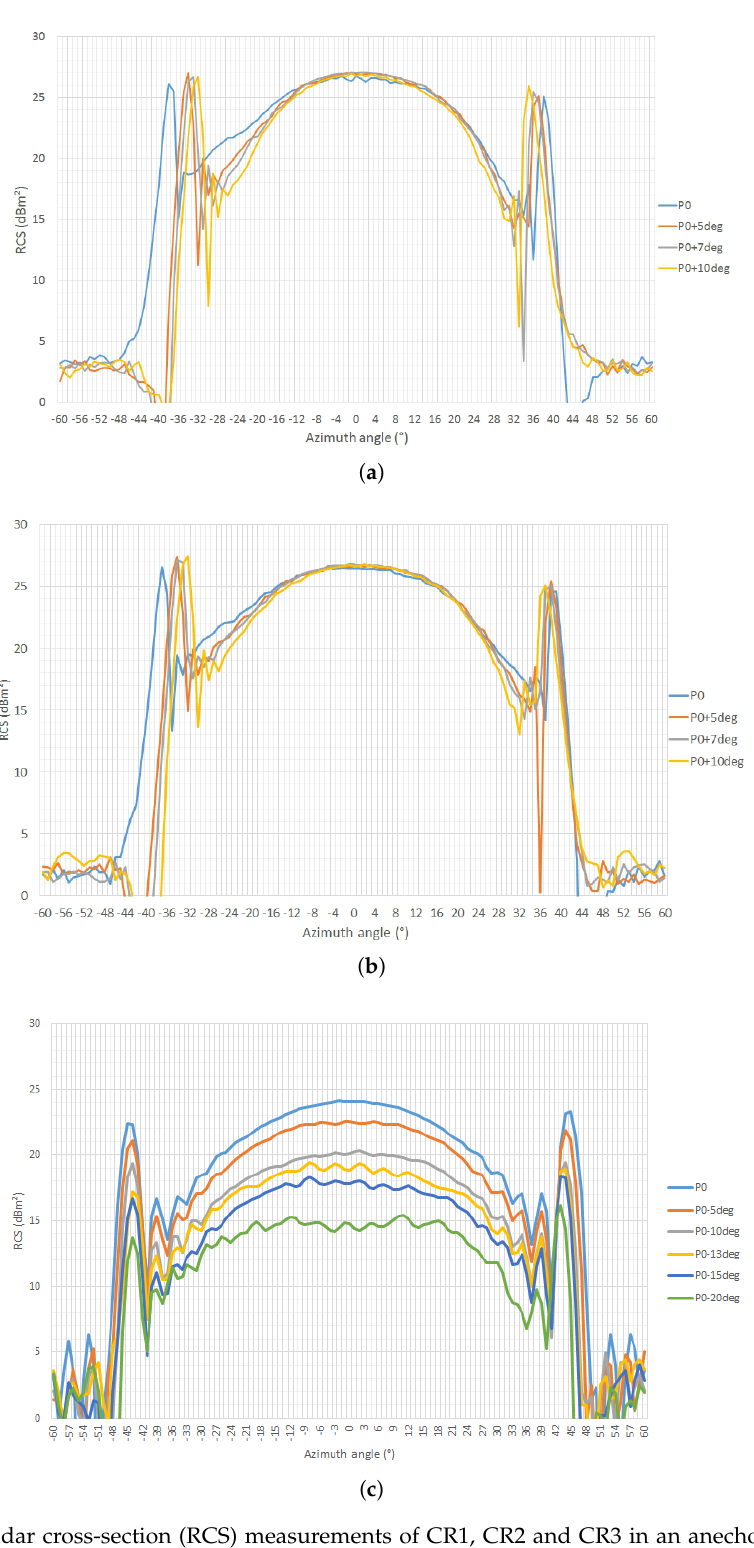
Figure 3. Radar cross-section (RCS) measurements of CR1, CR2 and CR3 in an anechoic chamber. ( a ) RCS measurements of CR1 and ( b ) RCS measurements of CR2. Blue: optimal elevation angle. Red: +5 degrees, Grey: +7, Yellow: +10. ( c ) RCS measurements of CR3. Blue: optimal elevation angle. Red: +5 degrees, Grey: +10, Yellow: +13. Dark blue: +15, Green: